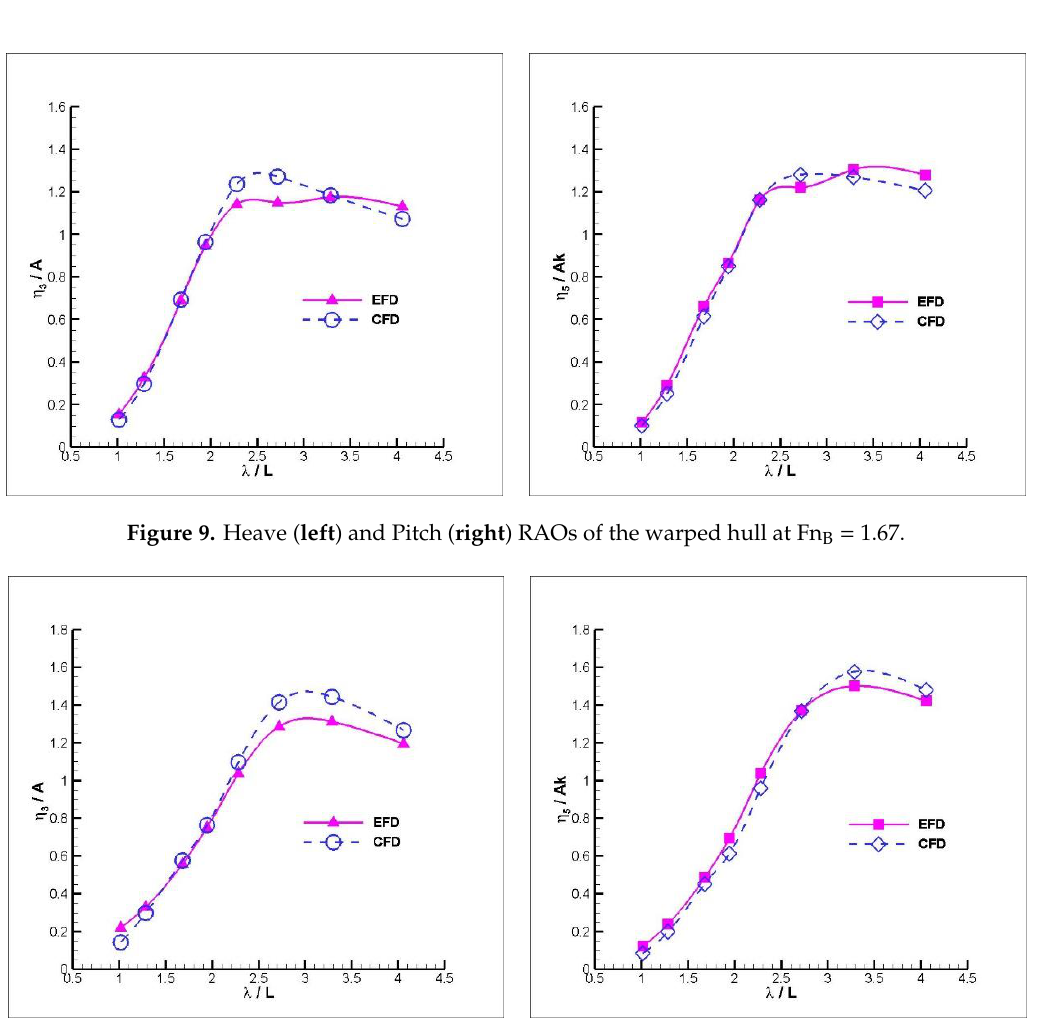
Figure 8. Heave ( left ) and Pitch ( right ) RAOs of the mono hull at Fn B = 2.82.